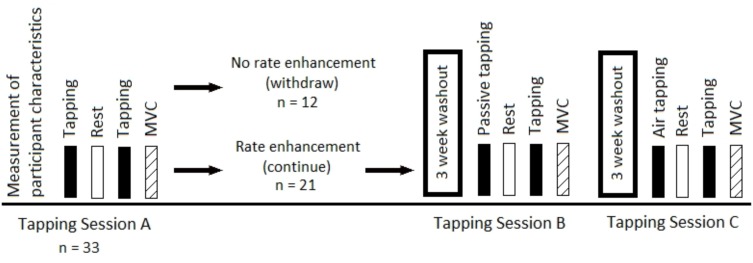
Illustration of the design of Experiment 1. The order of Sessions B and C was counterbalanced and performed in a crossover fashion.